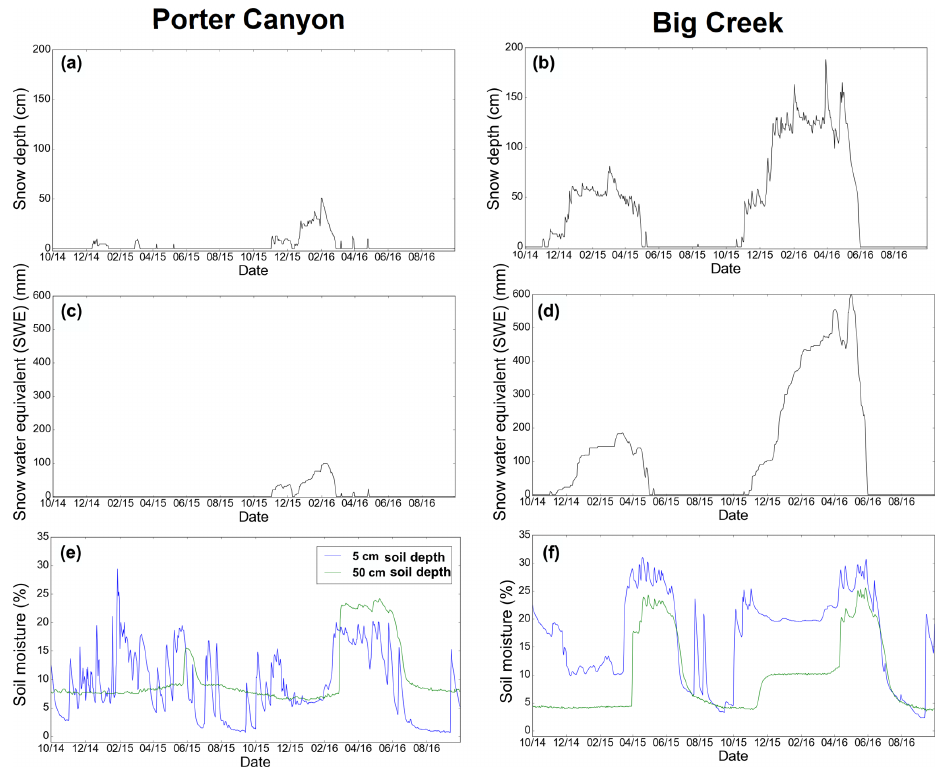
Figure 3. (a, b) Snow depth, (c, d) snow water equivalent, and (e, f) soil moisture measured at Porter Canyon and Big Creek Snow Telemetry (SNOTEL) stations for water years 2015–2016, which were a drought year and a typical year, respectively.